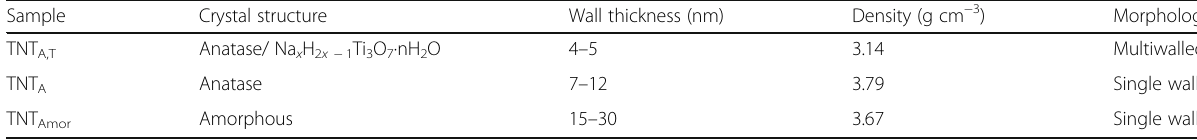
Table 1 Properties of the nanotube powders used for preparing samples for the thermal conductivity studies Sample Crystal